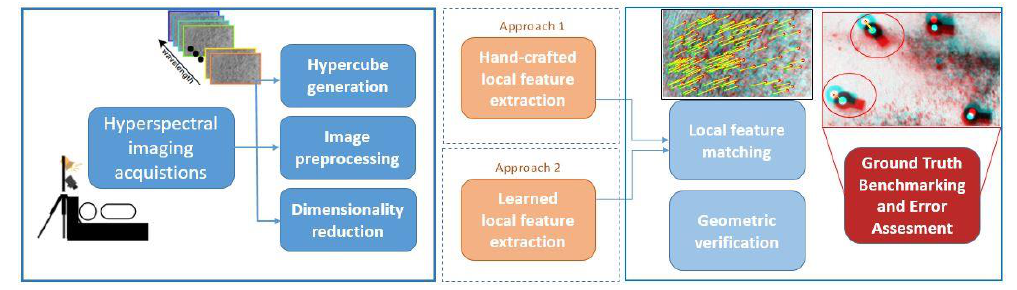
Figure 1. Schematic view of the complete framework. The hyperspectral (HS) cubes are preprocessed and used for feature detection and matching in order to estimate the 2D feature localization. The 2D Euclidean distances for the matched inliers are computed and compared with the Euclidean distances found with the optical markers, which represent the ground truth in this